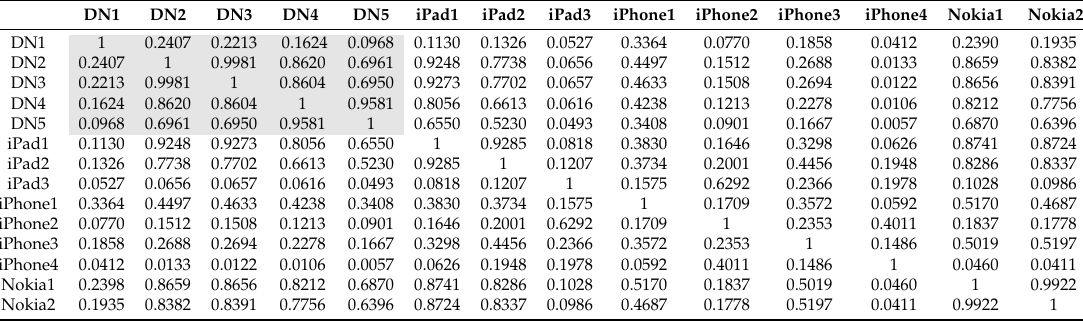
Table 5. R 2 values for 50,000 bins histograms for iPerf TCP IATs for the traces from the 14 devices described in Table